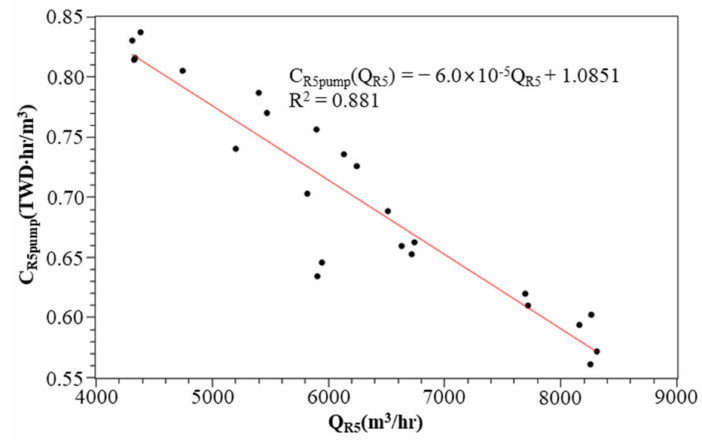
Figure 12. WTP R5 unit water discharge pumping cost